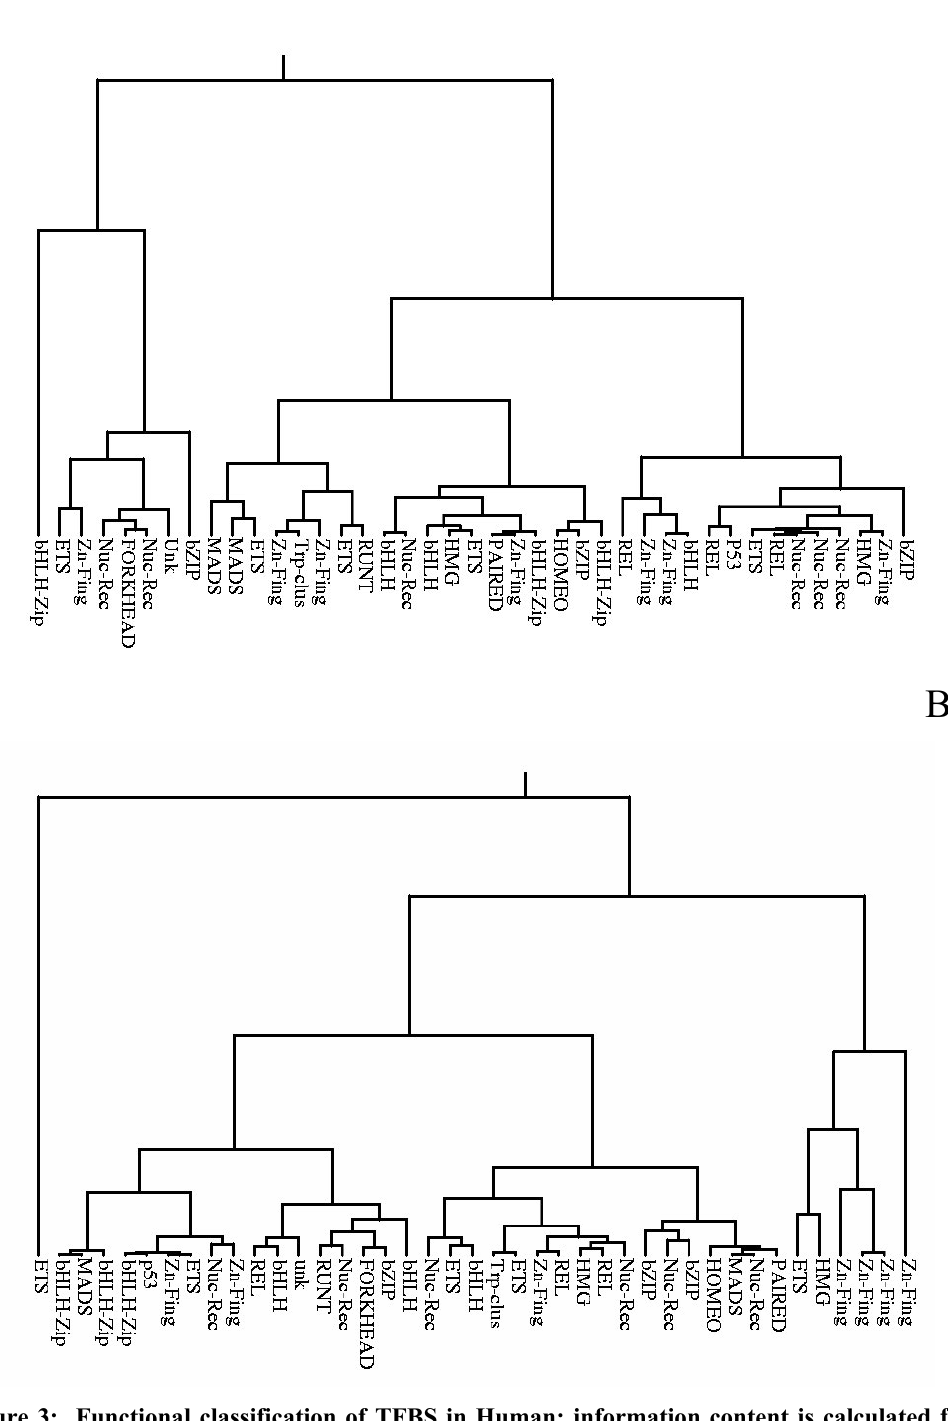
Figure 3: Functional classification of TFBS in Human; information content is calculated from nucleotide (A) neighbor-independent and (B) neighbor-dependent substitution